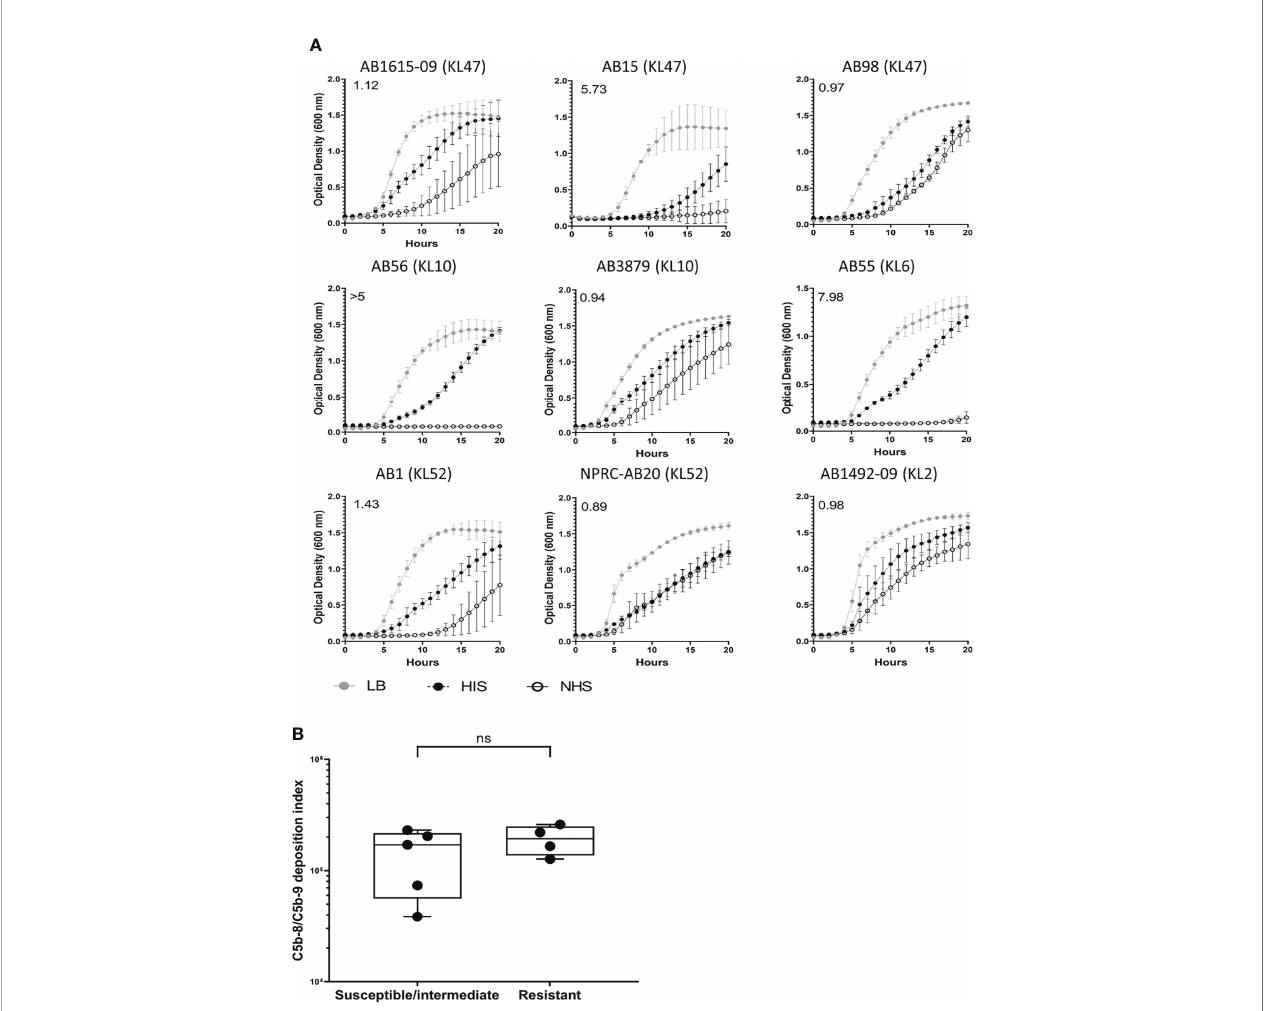
FIGURE 6 | Clinical A. baumannii isolates predominantly show resistant or delayed sensitivity to human complement. 10 6 CFU of bacteria was incubated with 50% normal sera or 50% heat-inactivated sera and the bacterial growth monitored over 24 hours with OD 600nm measurements obtained every 30 minutes. (A) Growth curves showing bacterial OD600nm measurements over 24 hours obtained from bacteria incubated with either LB broth (grey circle), heat-inactivated sera (black circles) or normal human sera (open circle). Numbers on the top left corner indicate the doubling time ratio. (B) Box and whisker graph comparing C5b-8/C5b-9 deposition levels in isolates classi fi ed as either susceptible, intermediate, or resistant to complement lysis. Line graphs indicate the mean value, and the error bars indicate standard deviations (SDs) (n = 9). Pooled data from three independent experiments is shown. ns: p-value >